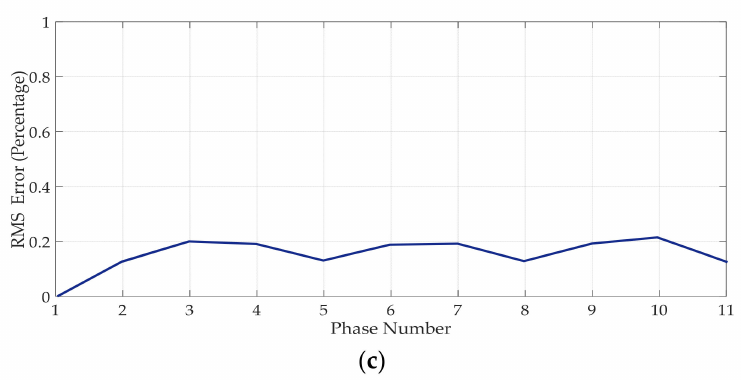
Figure 9. Root mean square (RMS) error in the process of elimination of elements for matrix Mx